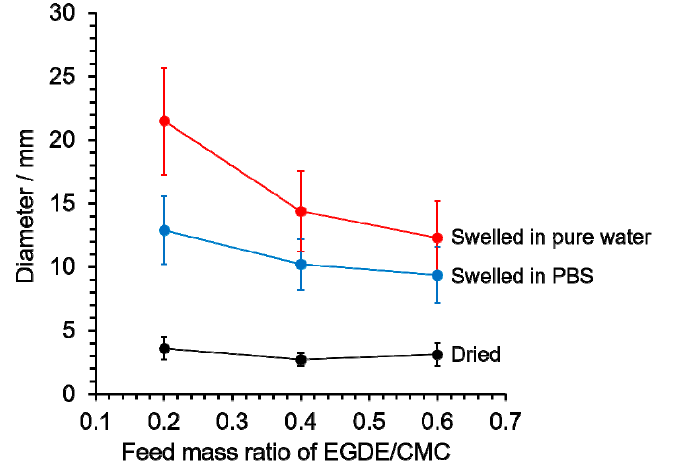
Figure 9. Effect of the mass ratio of ethylene glycol diglycidyl ether (EGDE)/cellulose sodium salt (CMC) on the dried CMCGs and on those swollen in PBS and pure water.